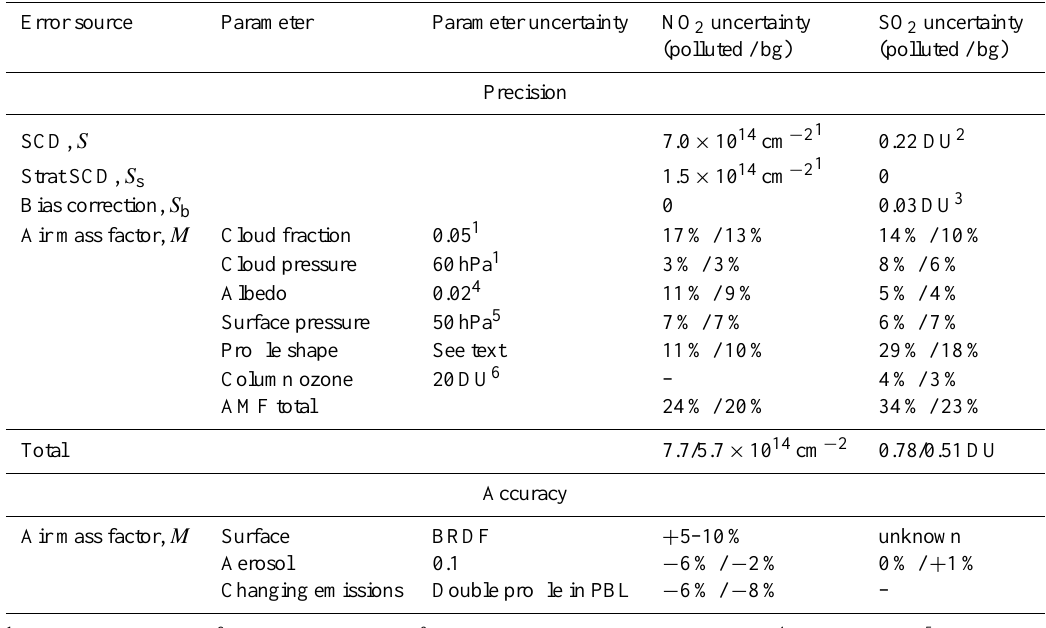
Table 3. Error budget for EC-VCDs considering cloud-free observations ( w <0.2). “Polluted” refers to observations made within 50km of the reference location; “background” (bg) from 50 to